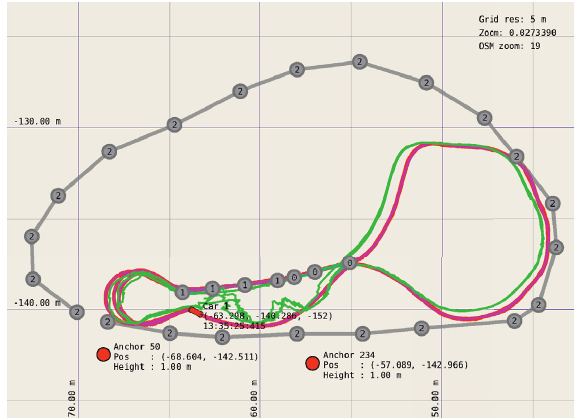
Figure 14: One test repeated three times with FI enabled. The traces for them are overlayed and mostly overlapping. Maximum UWB deviation: